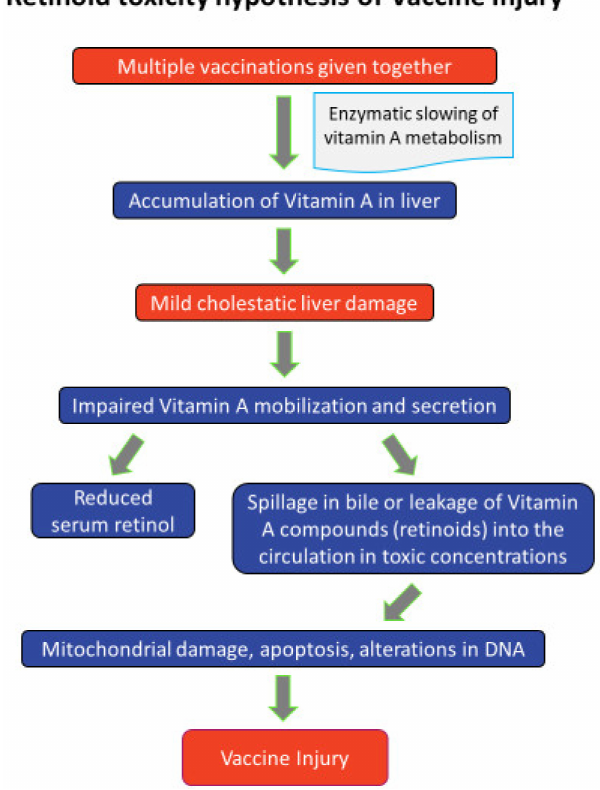
Figure 1. Retinoid toxicity hypothesis of vaccine